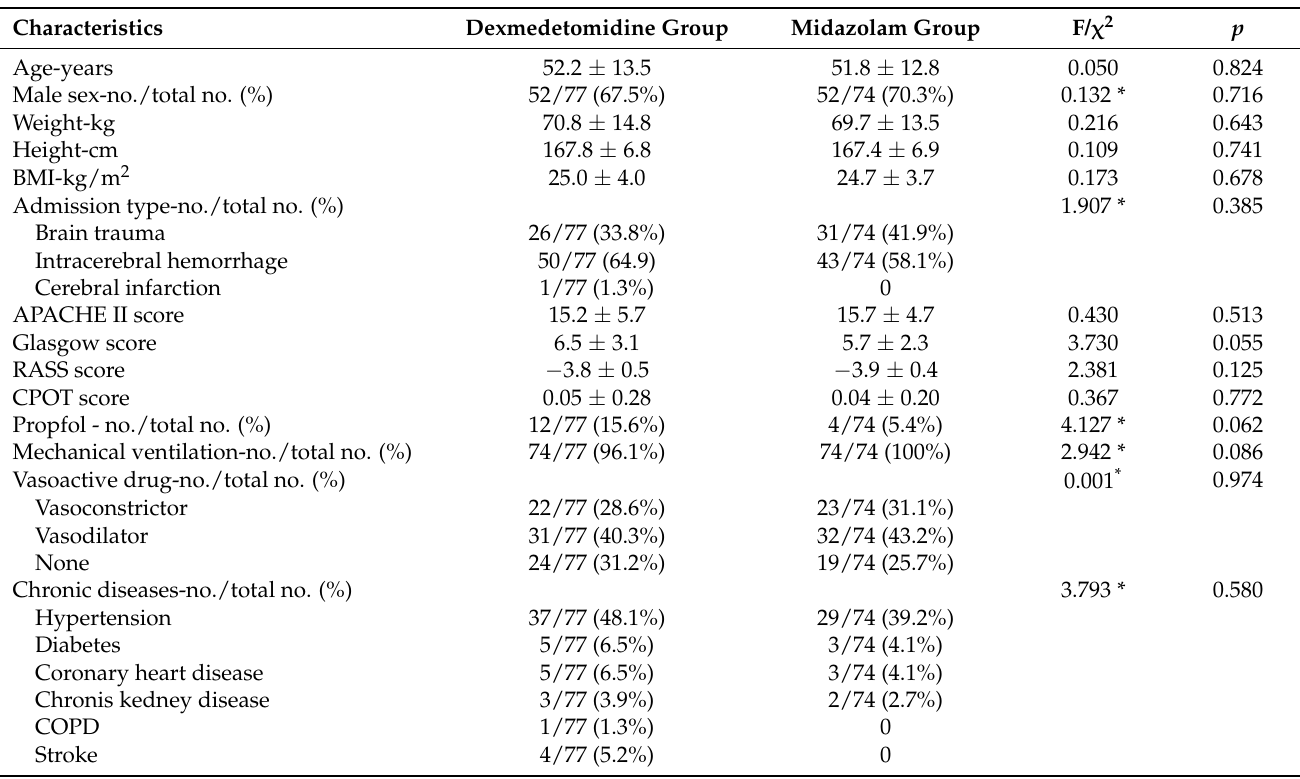
Table 1. Demographic and clinical characteristics of the Patients at Baseline.